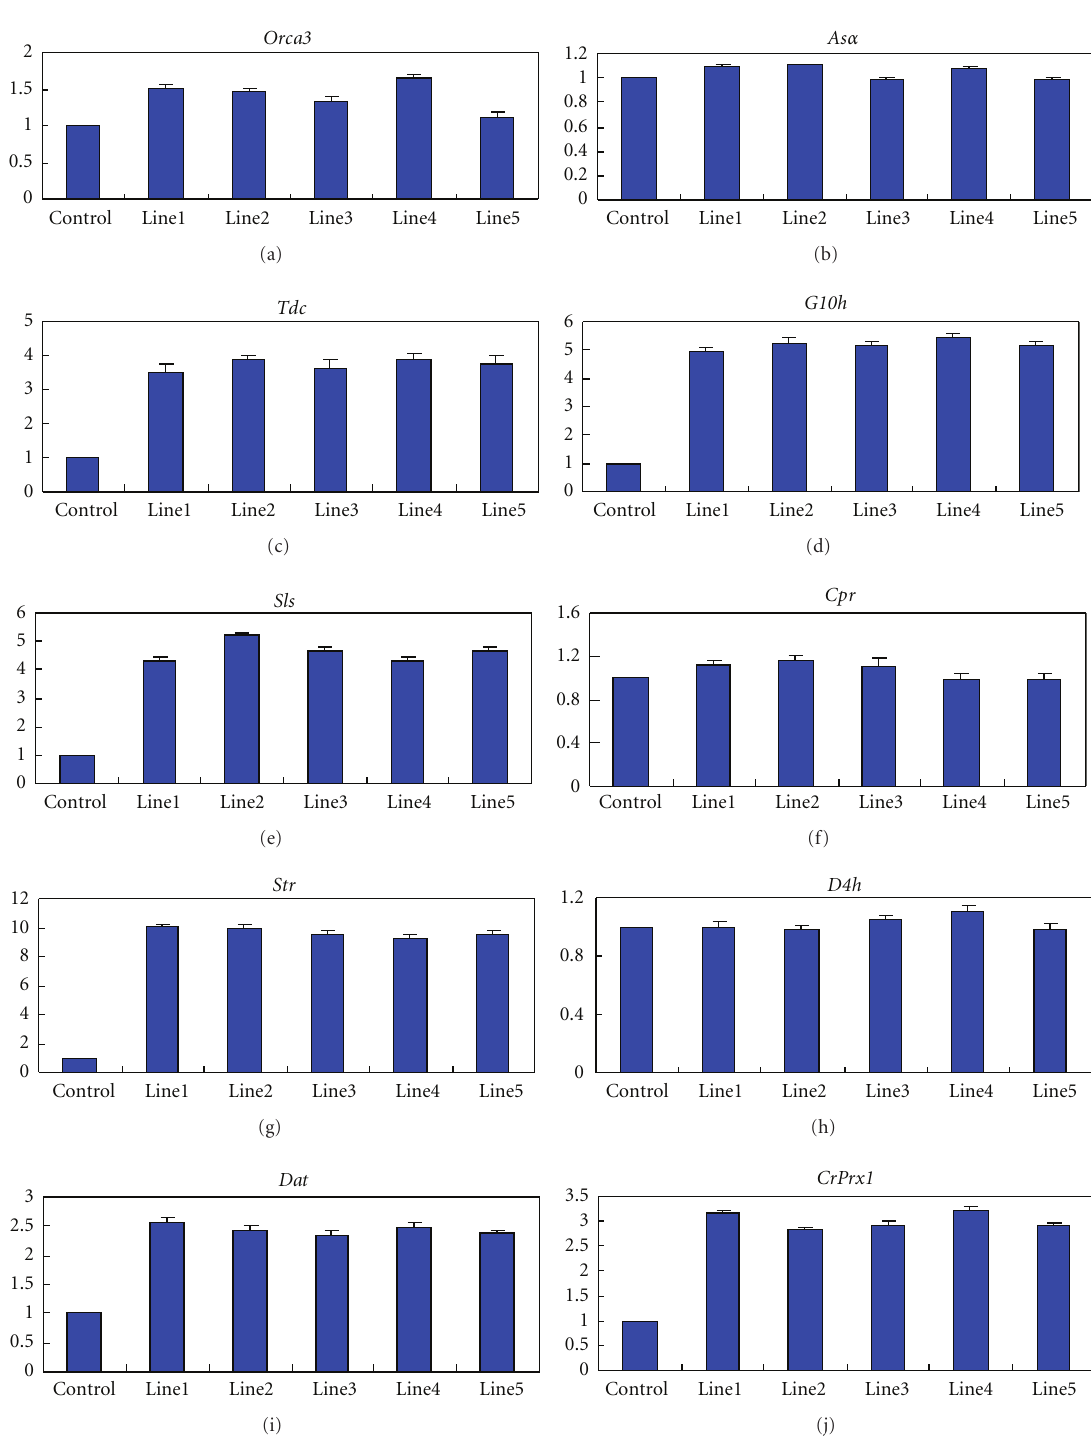
Figure 5: Quantitative real-time PCR analysis for the expression of ten genes in five tetraploid lines and three diploid lines which were also treated with colchicine solution in C. roseus . The average value relative expression of the controls was set to 1 level. The genes analyzed are Orca3 (a), As α (b), Tdc (c), G10h (d), Sls (e), Cpr (f), Str (g), D4h (h), Dat (i), and CrPrx1 (j). The data of each line represented is average value of three replicates in each experiment, while the data of control represented is average value of three independent control plants with three replicates in each